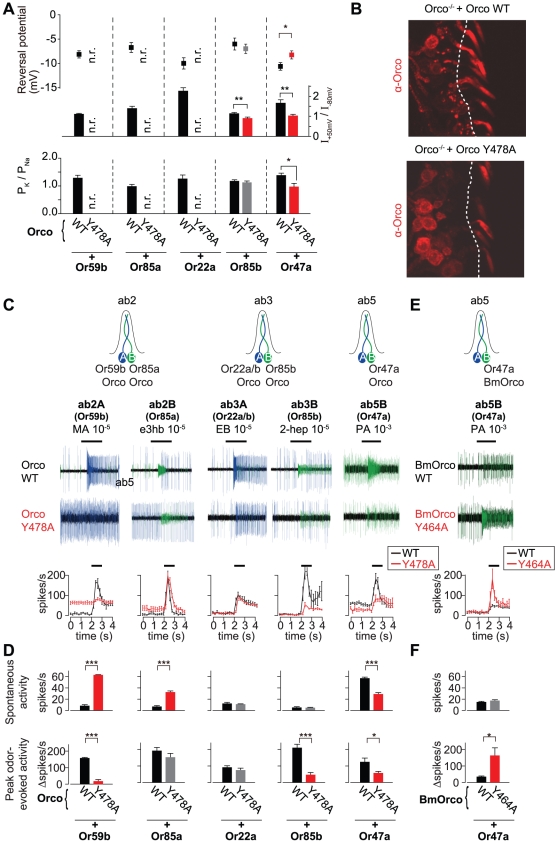
Effect of the Drosophila Orco Y478A mutation on Or-Orco function in heterologous cells and in Drosophila olfactory neurons.(A) Reversal potential (top), rectification index (middle), and permeability ratio (bottom) of oocytes expressing WT Drosophila Orco (black bars and symbols) or Drosophila Orco Y478A (red bars and symbols) along with WT ligand-selective Ors. Unpaired Student's t-test, mutant vs. WT, *p<0.05, **p<0.01. n.r. = no response. Data are shown as mean ± S.E.M., n = 8–10. (B) Anti-Orco antibody staining of WT Drosophila Orco (left) and Drosophila Orco Y478A expressed in Orco−/− animals. (C) (Top) Schematic of antennal sensilla showing the sensilla type and associated ligand-selective Ors. (Middle) Representative single-sensillum traces of ab2A, ab2B, ab3A, ab3B, ab5B neurons expressing WT Drosophila Orco or Drosophila Orco Y478A to methyl acetate, ethyl-3-hydroxybutyrate, ethyl butyrate, 2-heptanone, and pentyl acetate, respectively. Blue traces represent ab2A and ab3A neuron; green traces represent ab2B, ab3B, and ab5A and B neurons. (Bottom) Peristimulus time histograms of recordings from WT (black) and mutant (red). Data are presented as mean ±S.E.M., n = 3–7, and raw spikes/sec are plotted. (D) Summary of effects of WT Drosophila Orco (black bars) and Drosophila Orco Y478A (red bars) on spontaneous activity (top; raw spikes/sec) and odor-evoked activity. (bottom; corrected to subtract spontaneous activity). Unpaired Student's t-test, mutant vs. WT, *p<0.05, **p<0.01, ***p<0.001. Data are shown as mean ±S.E.M., n = 3–7. (E) (Top) Schematic of ab5 sensilla expressing WT BmOrco or BmOrco Y464A. (Middle) Representative single-sensillum traces of ab5 neurons expressing WT BmOrco or BmOrco Y464A to pentyl acetate. Green traces represent ab5A and ab5B neurons. (Bottom) Peristimulus time histograms of recordings from WT (black) and mutant (red). Data are presented as mean ±S.E.M., n = 4–5, and raw spikes/sec are plotted. (F) Summary of effects of WT BmOrco (black bars) and BmOrco Y464A (red bars) on spontaneous activity (top; raw spikes/sec) and odor-evoked activity. (bottom; corrected to subtract spontaneous activity). Data are shown as mean ± S.E.M., n = 4–5. Unpaired Student's t-test, mutant vs. WT, *p<0.05, **p<0.01, ***p<0.001.